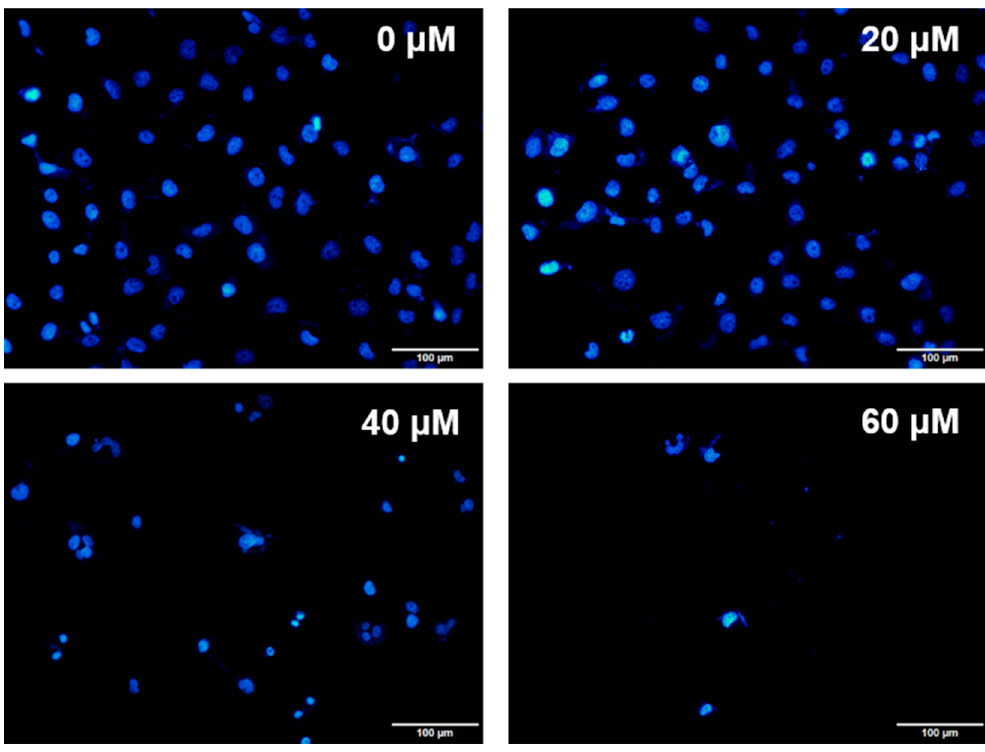
Figure 4. The nuclear morphology in Huh-7 by DAPI staining. Huh-7 cells after treatment with doses of UA for 24 h. Observations were taken under an Olympus IX81 microscope.